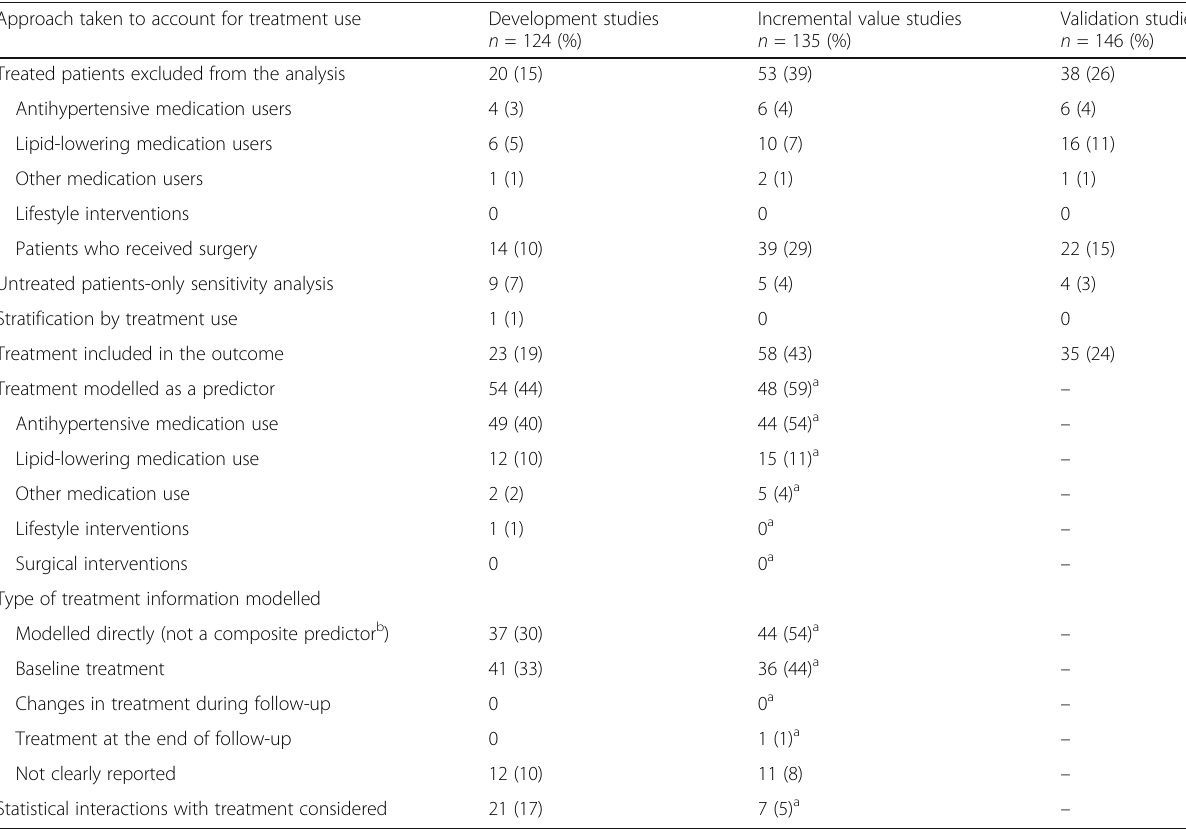
Table 3 Handling of treatment in the analyses of prognostic model studies Approach taken to account for treatment use Development studies